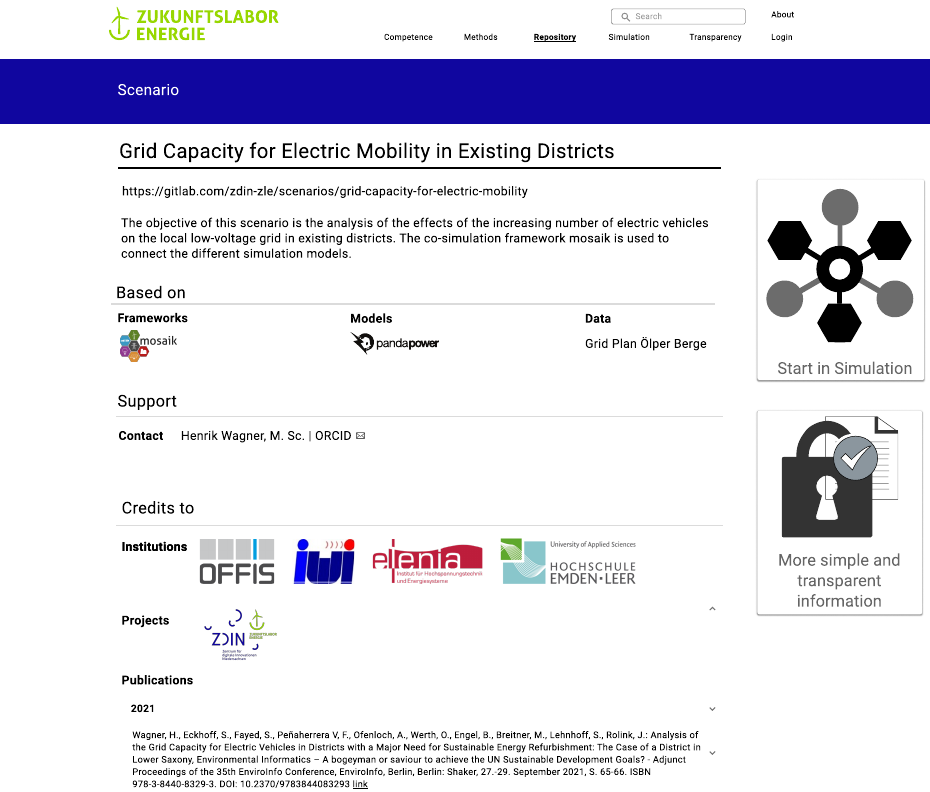
Figure 6. Mockup of an Artifact View page for a scenario with links to Competence in the credits to part and links to Simulation and Transparency on the